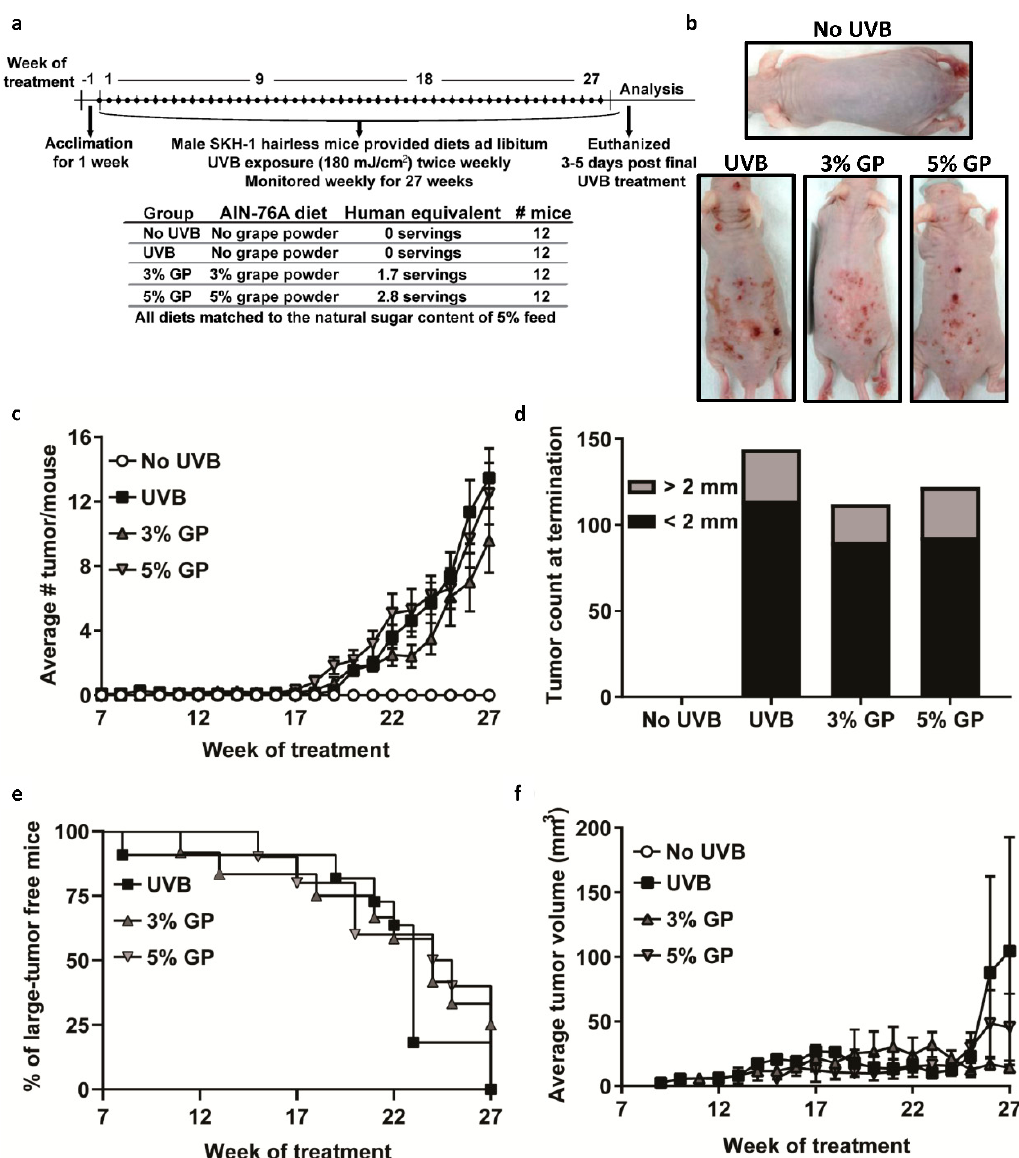
Figure 2. Dietary GP consumption reduces UVB-mediated skin carcinogenesis in male SKH-1 hairless mice. ( a ) Timeline of chronic UVB-mediated carcinogenesis study. ( b ) Representative SKH-1 mice from each group at the end of the study. ( c ) Average number of total tumors per mouse per group. ( d ) Additive large (>2 mm diameter, grey) and small (<2 mm diameter, black) tumor count at termination of the experiment. ( e ) Large tumor latency shown as the percentage of mice without measurable tumors (>2 mm in diameter). ( f ) Average tumor volume of measurable tumor per group. All data are presented as the mean ± SEM.